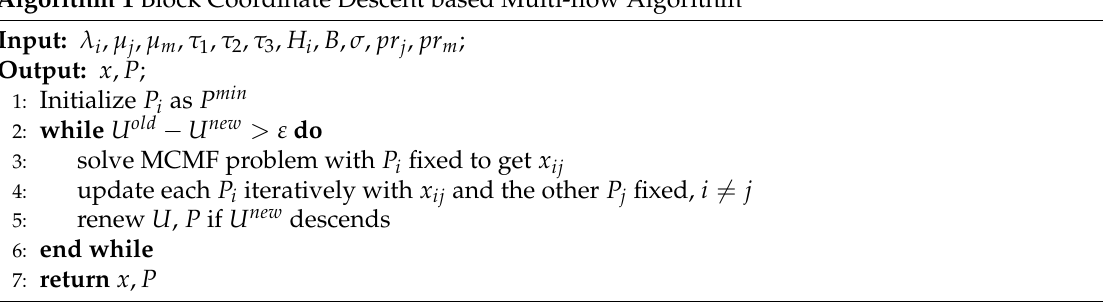
Figure 3. The Minimum Cost Maximum Flow Model for the CDF problem in IFEC. Algorithm 1 Block Coordinate Descent based Multi-flow Algorithm